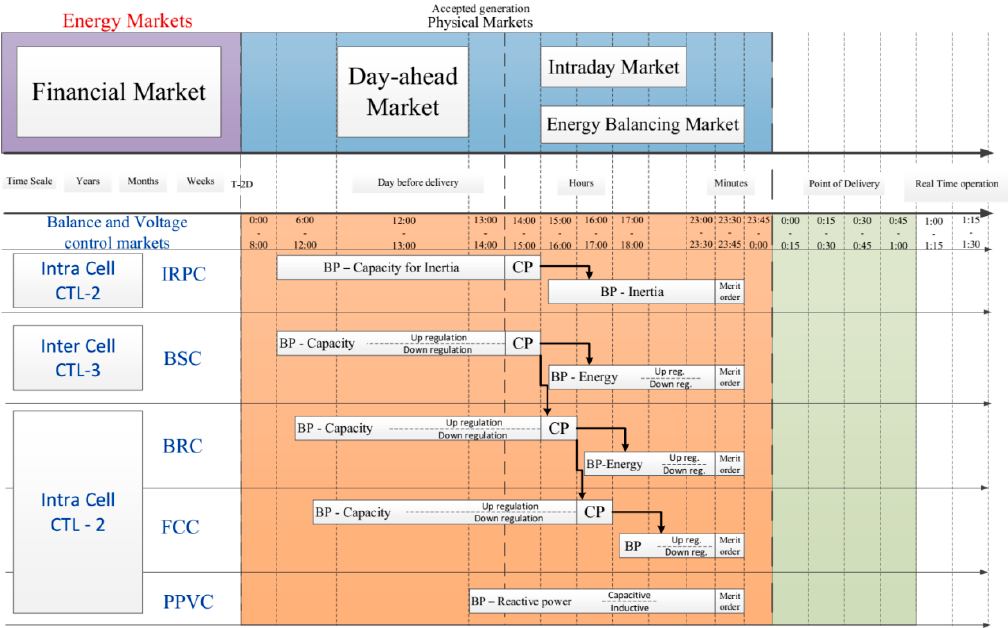
Figure 5. Market sequence organization under the WoC concept [35].